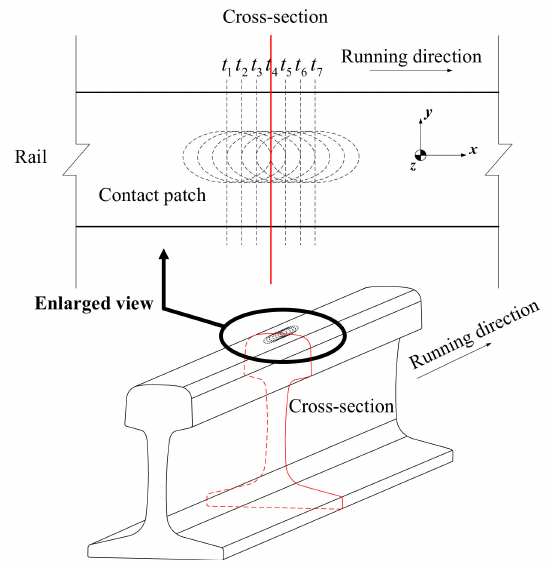
Figure 12. Diagram of superposition of rail profile